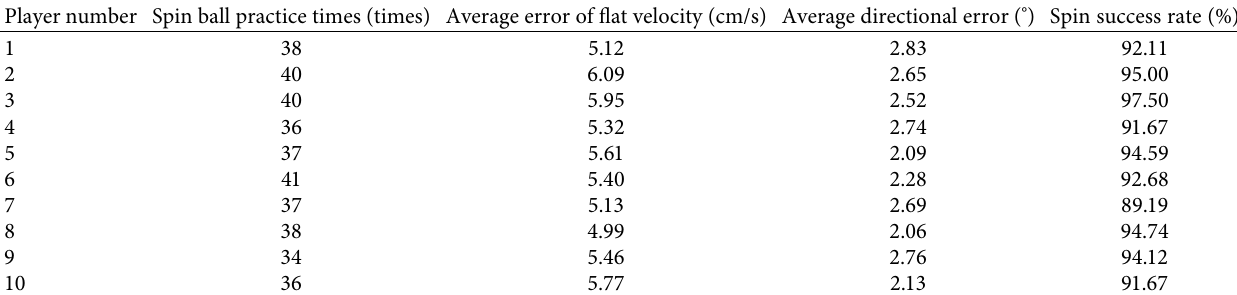
Table 8: Training results of athletes after using data mining